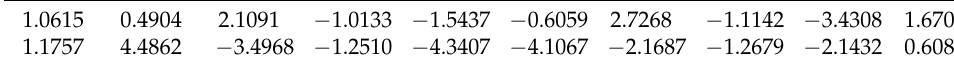
(cid:2) (cid:3) LW 2,1 ). 2 × 10